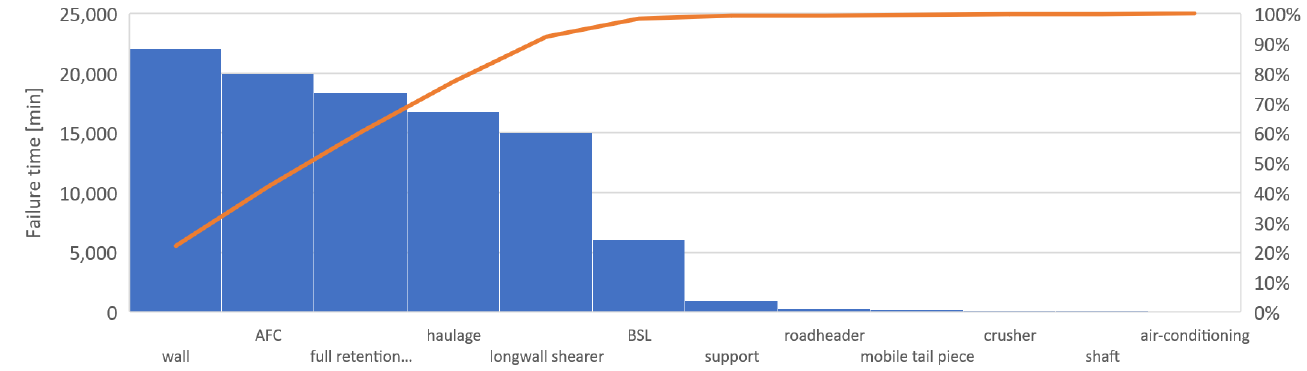
Figure 7. Pareto chart for the total duration of shearer longwall failures.